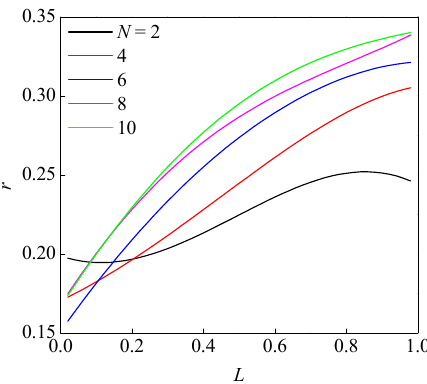
Figure 8. Results of the power to heat ratio r for varied gap L and number of mirrors N in configuration 2.